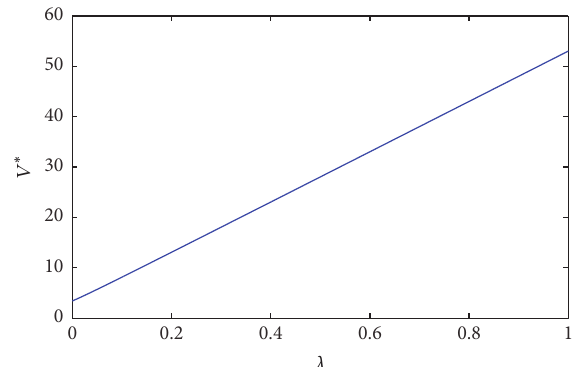
Figure 2: The relationship between the funding threshold 𝑉 ∗ and major events uncertainty 𝜆 . 𝜎 = 0.2; 𝑟 = 0.04 ; 𝛿 = 0.02; 𝐼 1 =